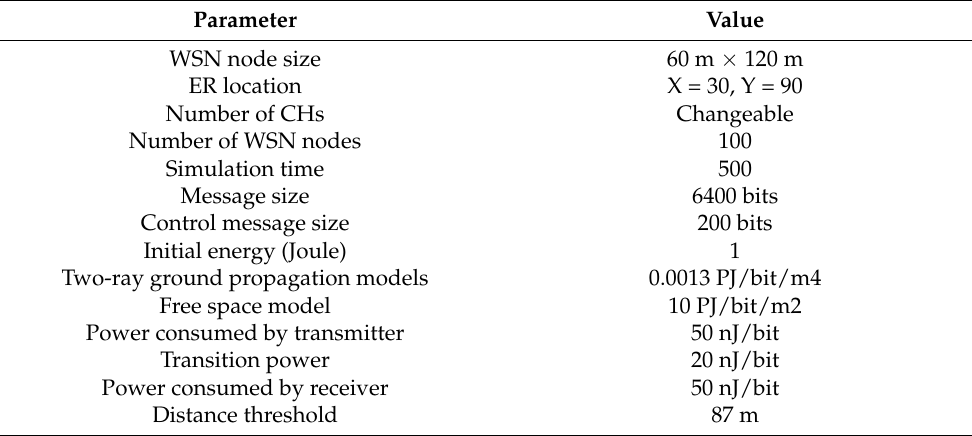
Table 9. Simulation parameters